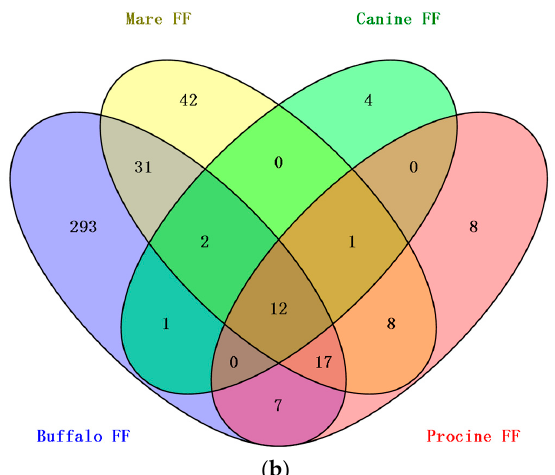
Figure 3. Venn diagram analysis of overlapping proteins: ( a ) overlapping analysis of proteins identified from HFF and BFF; and ( b ) overlapping analysis of proteins identified in the follicular fluid of four mammalian species.